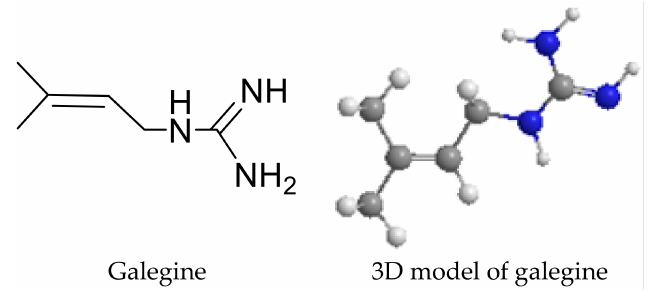
Figure 1. Scheme of the structure of galegine.